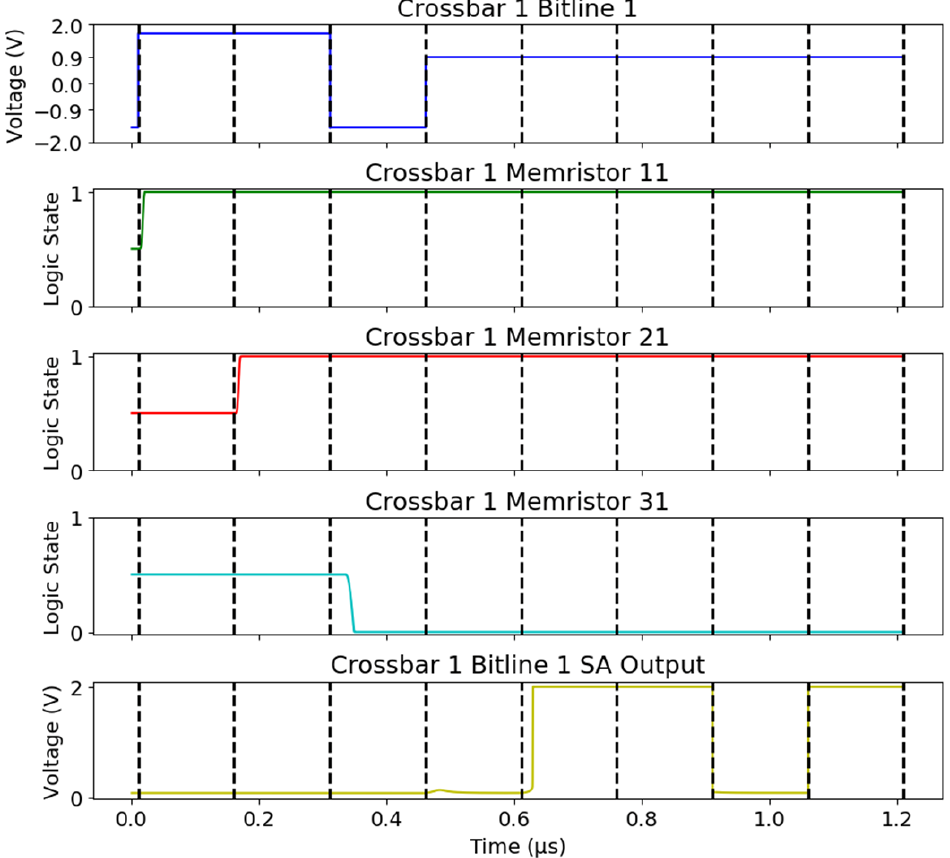
Figure 11. Circuit simulation results for operations performed in a single bitline of the computational ReRAM. From top to bottom, we observe the voltage applied to bitline BL 1 , the evolution of the logic state (expressing conductivity in the model) of the memristors in words 1–3 connected to BL 1 (notation “memristor XY” in the legend means wordline X and bitline Y), and the output voltage of the SA connected to OL 1 . Logic “1” corresponds to 2 V in the SA output voltage. Vertical dashed lines designate different 150 ns–wide cycles of operation.